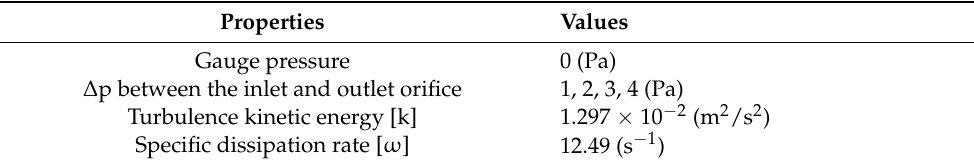
Table 2. Airflow properties of the CFD simulations for the investigation of the transport phase of the measurement